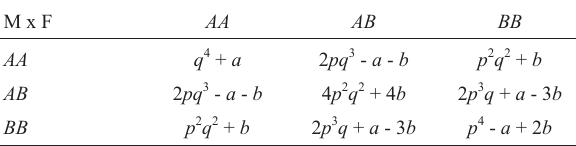
Table 3 - Li’s symmetric non-random mating model.